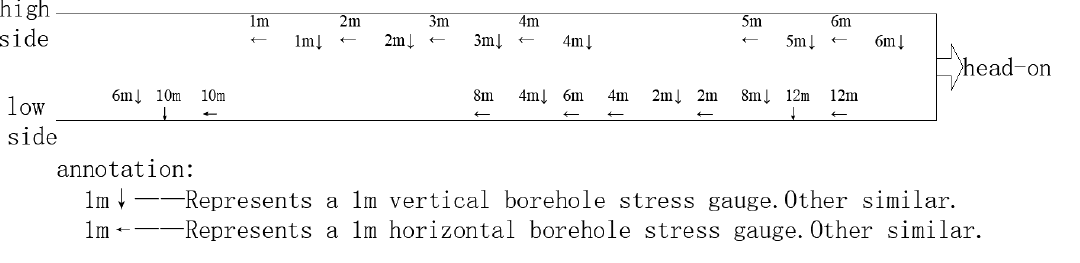
Figure 3. 11613 Schematic diagram of section layout of measuring station.